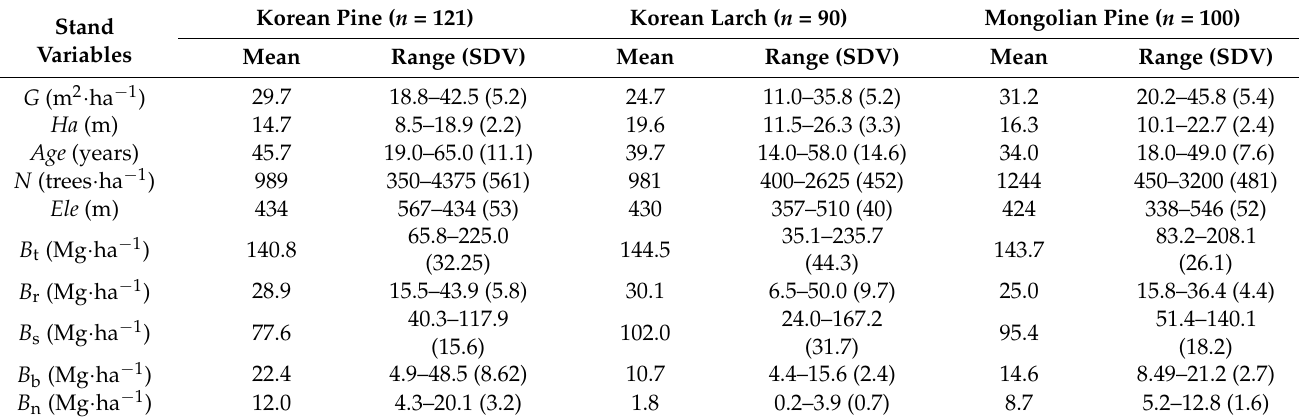
Table 1. The statistical information of stand variables and biomass